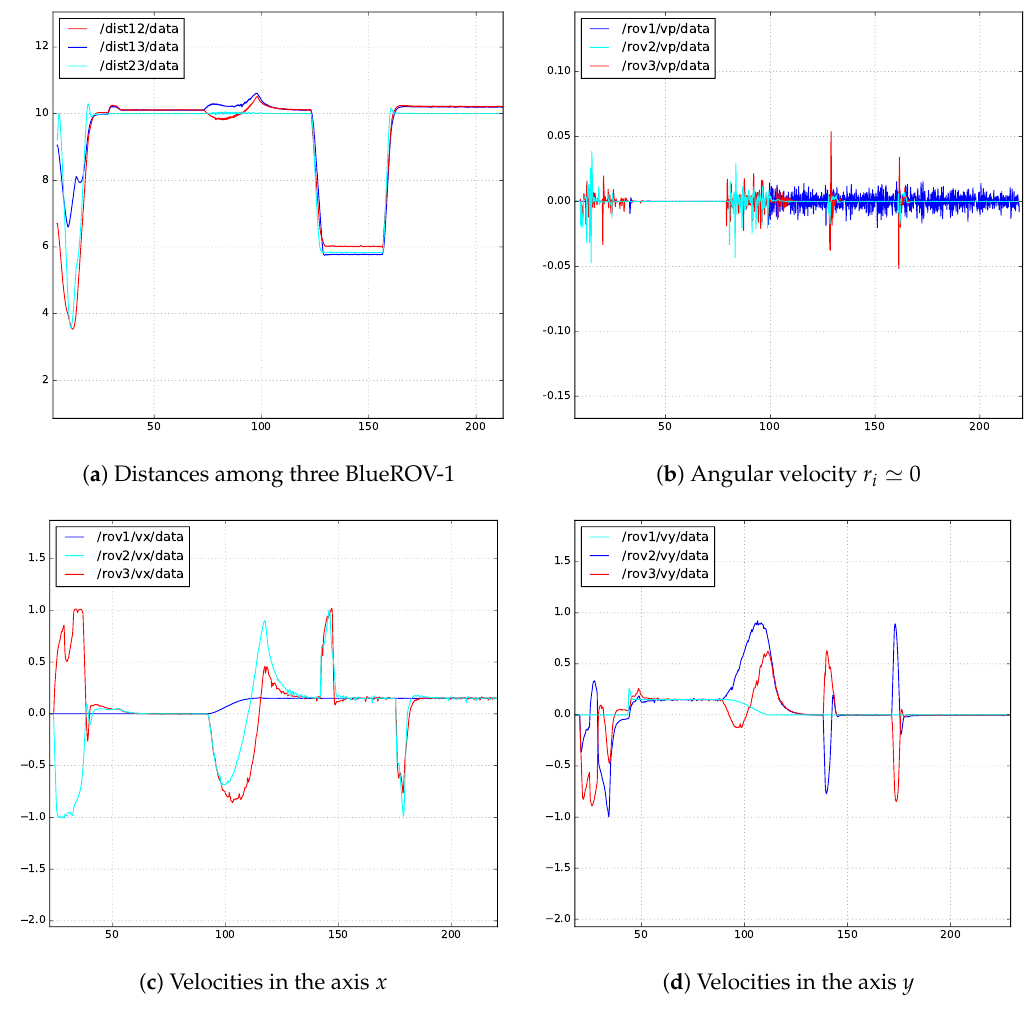
Figure 6. A complete simulation scenario with three